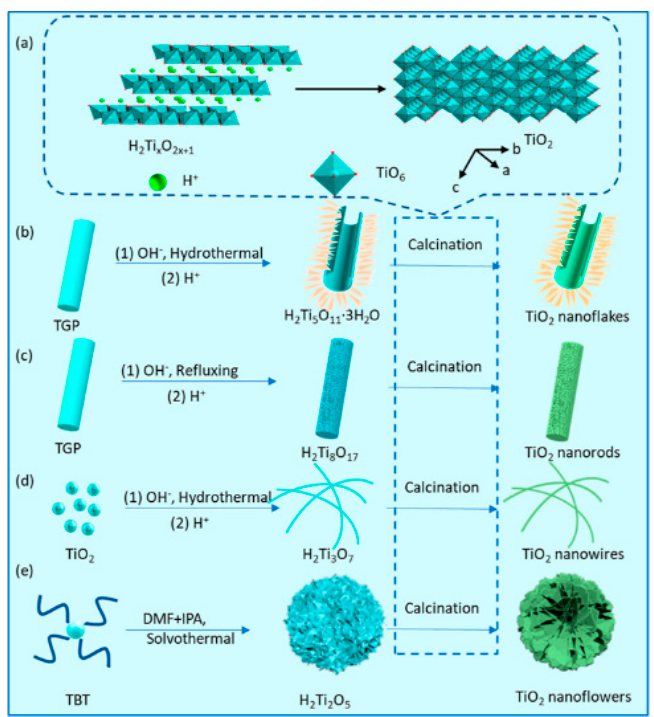
Figure 2. ( a ) Illustration for crystal phase transformation of TiO 2 from protonic titanate during the calcination process and illustration for the formation of different TiO 2 nanostructures from protonic titanate to: ( b ) TiO 2 nanoflakes, ( c ) TiO 2 nanorods, ( d ) TiO 2 nanowires and ( e ) TiO 2 nanoflowers [46]. Reprinted with permission from [46] Copyright 2022 American Chemical Society.